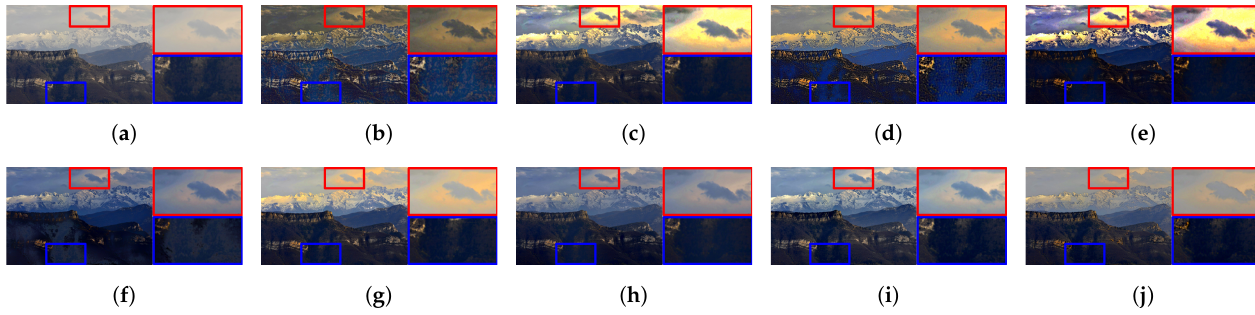
Figure 20. A qualitative comparison of different dehazing methods on a real hazy image of mountains. ( a ) Hazy image, and results by ( b ) Tarel and Hautiere [35], ( c ) He et al. [21], ( d ) Kim et al. [36], ( e ) Bui and Kim [50], ( f ) Zhu et al. [52],